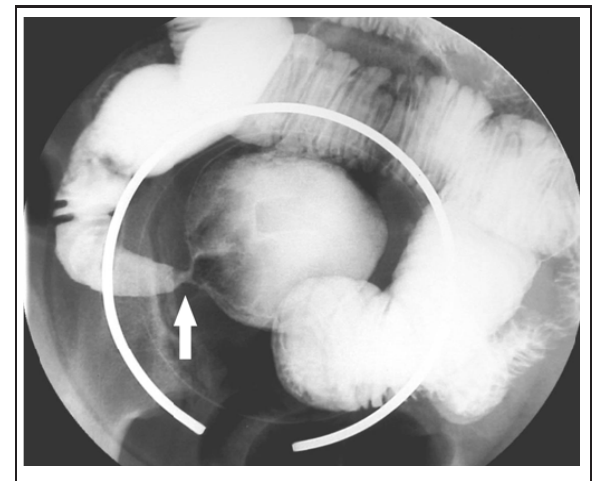
Figure 4. Enteroclysis- Spot film from enteroclysis shows small-bowel loop narrowing (white arrow) due to postoperative